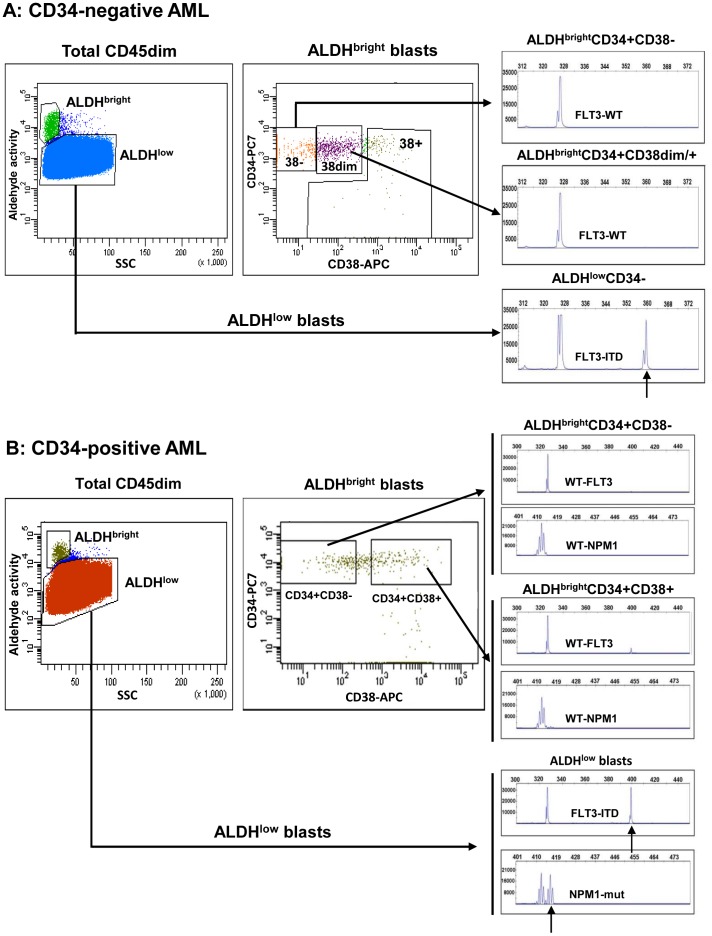
The presence of FLT3-ITD and mutated NPM1 in ALDHbright CD34+CD38− progenitor populations.(A) In CD34-negative AML cases, the ALDHbright population of AML cells consists, besides CD34+CD38− stem cells of CD38dim and CD38+ progenitors (A, middle panel, AML-464) (Table S3). The complete ALDHbright compartment in CD34-negative AML has a normal phenotype as proven by the absence of FLT3-ITD in the CD34+CD38− (A, right upper panel) as well as the CD38dim (A, right middle panel) and CD38+ (data not shown) population of cells. The ALDHlow compartment contains the FLT3-ITD (arrow in right lower panel), indicating leukemic cells. (B) In CD34-positive AML cases, the ALDHbright population contains, apart from normal CD34+CD38− HSC, CD34+CD38+ progenitors and CD34− cells (Figure 5B middle panel)(Table S3). The ALDHbright CD34+CD38− stem cells lack molecular aberrancies (B, right upper two panels) and are therefore normal. The CD34+CD38+ progenitor compartment (B, right middle two panels) in this case has very small FLT3-ITD and NPM1 mutant peaks likely originating from purification of ALDHlow cells within the ALDHbright compartment. The ALDHlow compartment is largely neoplastic (B, right lower 2 panels).